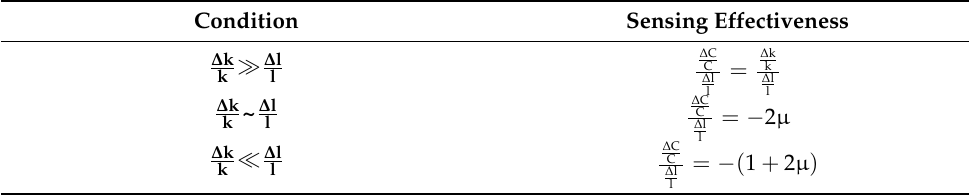
Table 11. Conditions adopted for determining sensitivity nature.